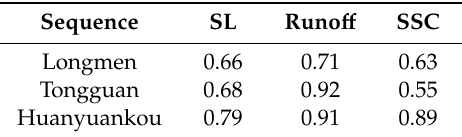
Table 6. Hurst exponents of hydrological series SL, runo ff ,